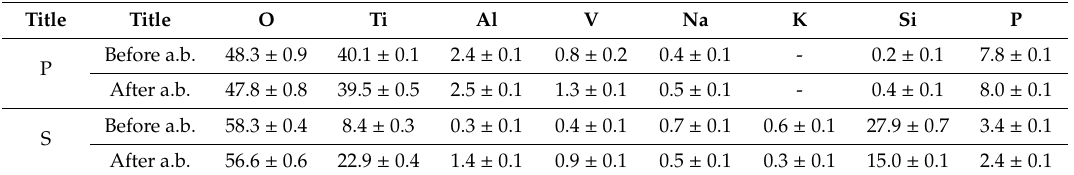
Table 3. Surface composition of the PEO layers (EDS, wt.%; average data, recorded on several areas imaged at 500 × on each sample) before and after abrasive blasting